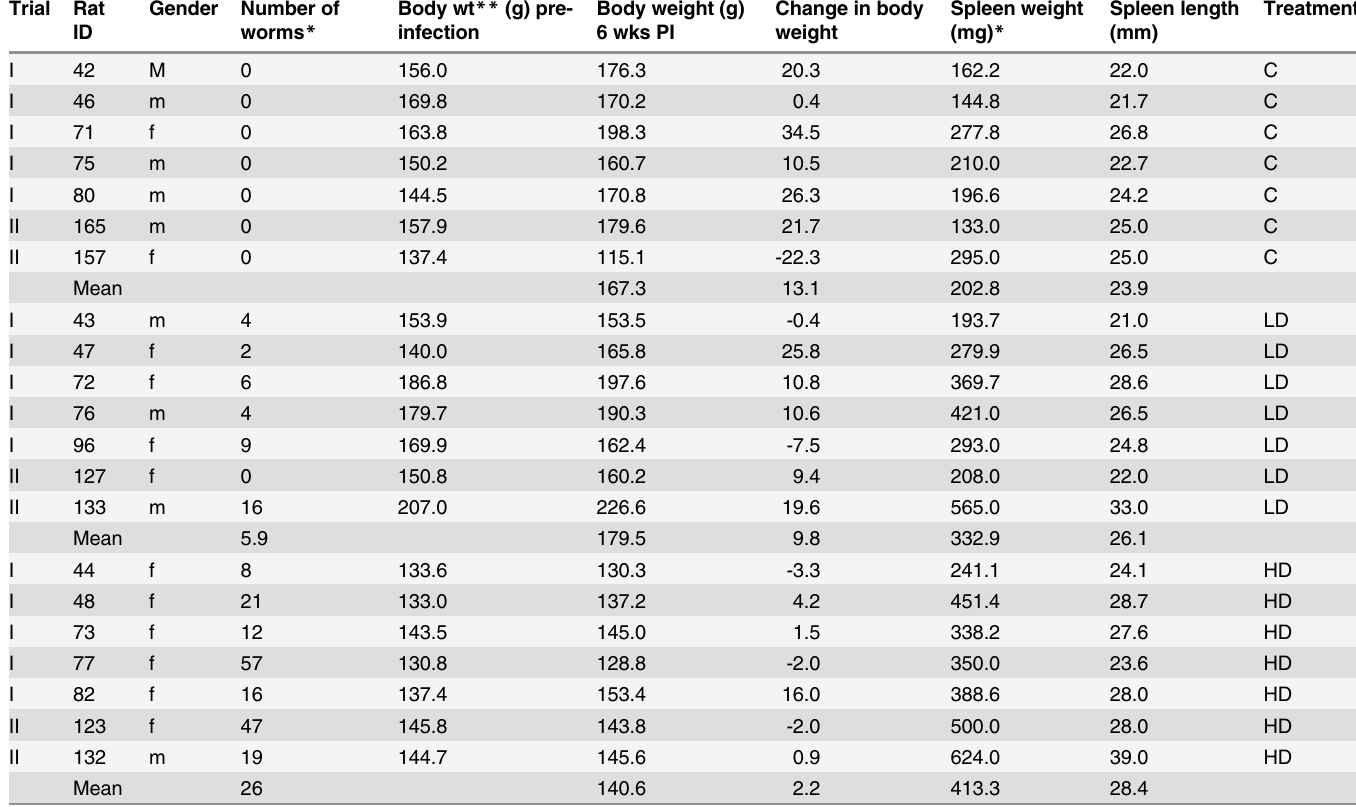
Table 1. Summary of the rat identification and measurements recorded during the trial including gender, number of worms recovered at necropsy, body weights prior to infection and at 6 weeks PI, spleen measurements and treatment group (C control, LD low dose, HD high